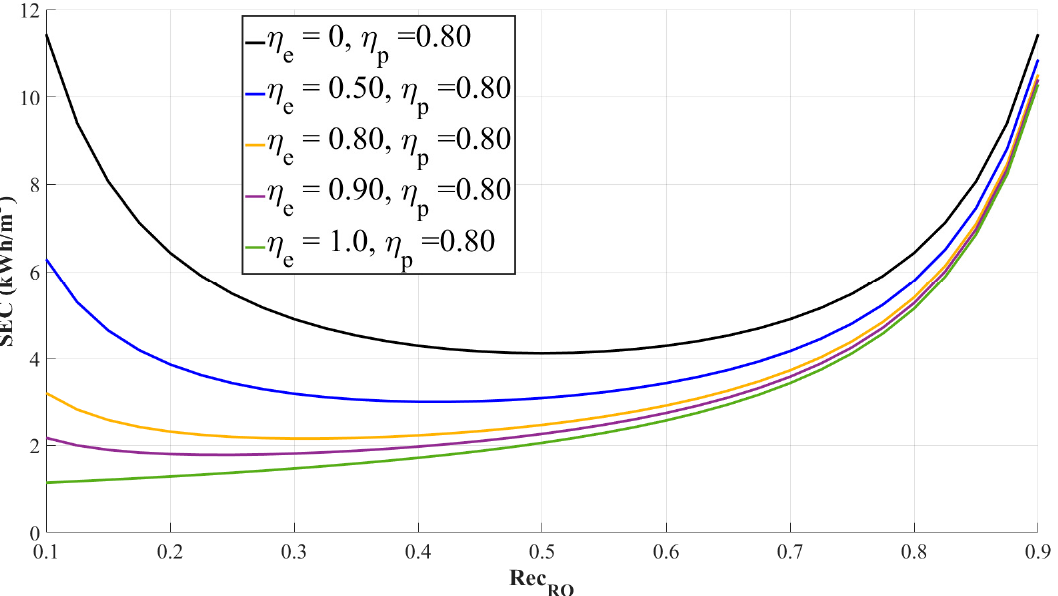
Figure 9. The plot depicting the specific energy consumption ( SEC ) trend in a stand-alone RO process. As shown in the figure, a graph with the zero of energy recovery device efficiency ( 𝜂 (cid:3032) ) displays an almost perfectly symmetric parabola shape, and its specific energy consumption becomes lowest at 0.5 of the water recovery rate. Meanwhile, parabolic trends in other graph lines descend as the efficiency of an energy recovery device increases. In this figure, 𝑅𝑒𝑗 = 100% ; 𝐶 (cid:3007),(cid:3029),(cid:3019)(cid:3016) = 35,000 ppm